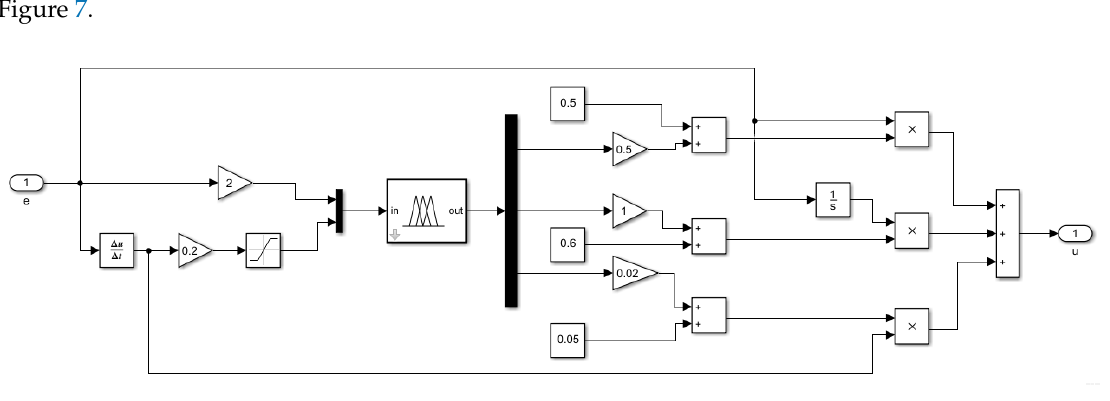
Figure 7. Adaptive fuzzy PID control simulation diagram.